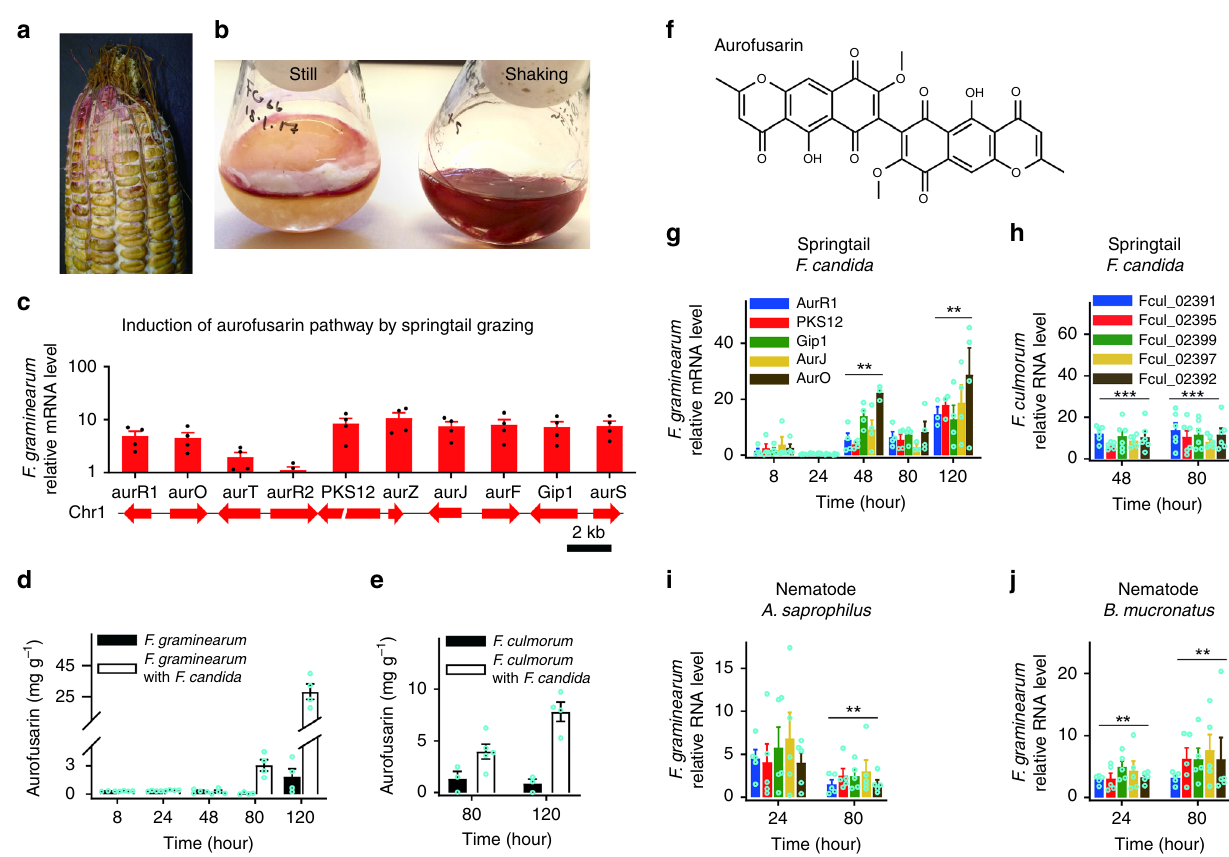
Fig. 2 Aurofusarin synthesis in Fusarium spp . is stimulated by predation. a An ear of corn inoculated with F. graminearum showing red pigment aurofusarin (courtesy of Dr Belinda J. van Rensburg, ARC South Africa). b F. graminearum cultures in potato broth. c Upregulation of genes of aurofusarin biosynthesis in F. graminearum after exposure to grazing by the springtail Folsomia candida for 48 h (RNAseq; n = 4; see Fig. 1 for details). d , e Aurofusarin accumulation in F. graminearum and F. culmorum exposed to grazing by the springtail Folsomia candida ( n = 4). f Structure of aurofusarin. g , h Upregulation of genes of aurofusarin synthesis in F. graminearum and F . culmorum after grazing by Folsomia candida (RT qPCR). i , j Upregulation of genes of aurofusarin synthesis after exposure to the fungivorous nematodes Aphelenchoides saprophilus and Bursaphelenchus mucronatus (RT qPCR). The gene cluster was labelled as signi fi cantly induced when mRNA levels of at least three genes increased at least threefold and the increase was statistically signi fi cant (** P < 0.001, *** P < 0.0001, two-tailed t test) with both reference genes (glyceraldehyde-3-phosphate dehydrogenase and elongation factor 1a). Error bars show s.e.m. Three to four biological replicates were used in RT qPCR (see Supplementary Data 3). Source data are provided in a Source Data fi